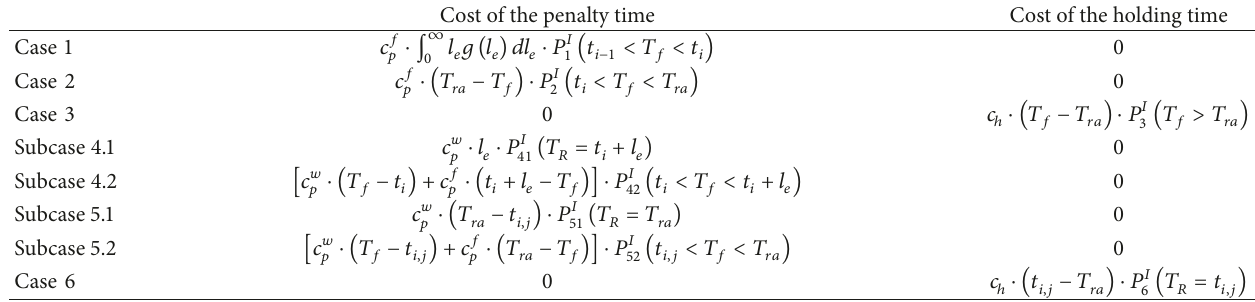
Table 2: Expected costs caused by the penalty time and the holding time.